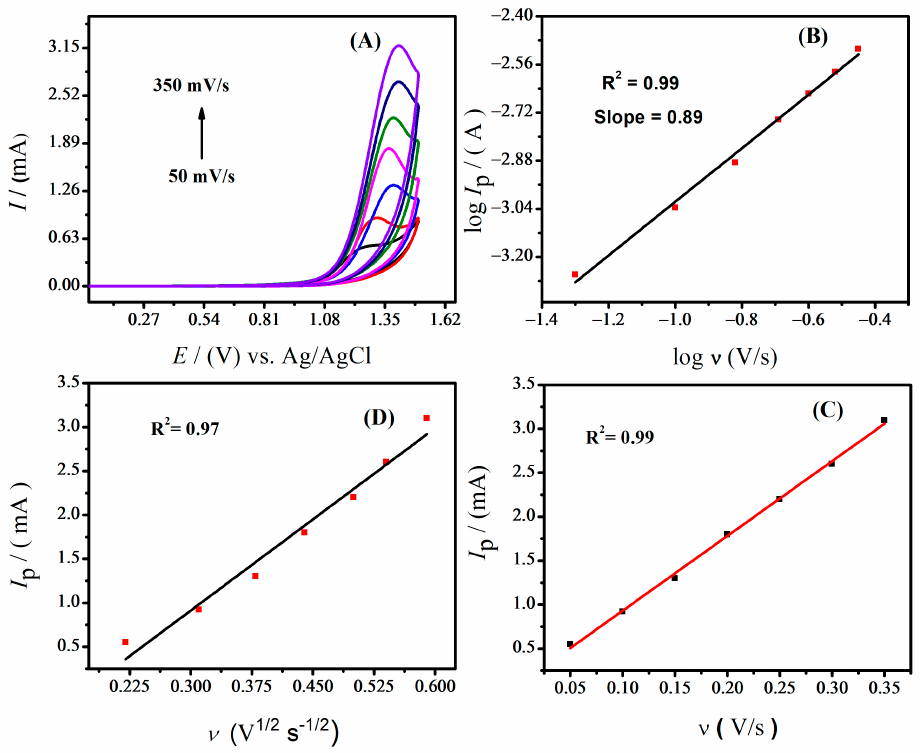
Figure 5. ( A ) Effect of different scan rates on the anodic peak current of IBP in supporting electrolyte (0.9 M NaOH), ( B ) calibration plot of IBP between log I p vs. log υ , ( C ) plot of peak current vs. scan rates of IBP oxidation, and ( D ) calibration plot of IBP between peak current vs. square root of scan rates. The slope value of the log of I p and log of ν plot can be used to deduce the nature of the redox process. If the value of the slope is 1, the process should be controlled by ad- sorption; on the other hand, if the slope value is 0.5 the process should be controlled by diffusion [26]. The slope value of 0.89 as depicted in Figure 5B suggests that the electro- chemical oxidation of IBP is controlled by both processes [27]. The straight-line equation for the graph shown in Figure 5B is represented by log I p = 0.89 and log v − 6.57. Since the correlation coefficient in the plot of oxidation peak current vs. scan rate is higher (Figure 5C) than that of I p vs. ν ½ (Figure 5D), the process of adsorption works better on the elec- trode’s surface. 2.5. Optimization of Experimental Parameters Among all the voltammetric techniques, DPV is the most sensitive pulse technique. Its detection limit is comparable to that achieved by chromatographic and spectroscopic approaches. After the sensing ability of the modified GCEs was tested with EIS, CV, and DPV, and the maximum current response was measured, the DPV method was used to find the best combination of experimental parameters to obtain the maximum current re- sponse. The following sections provide more information on these parameters.